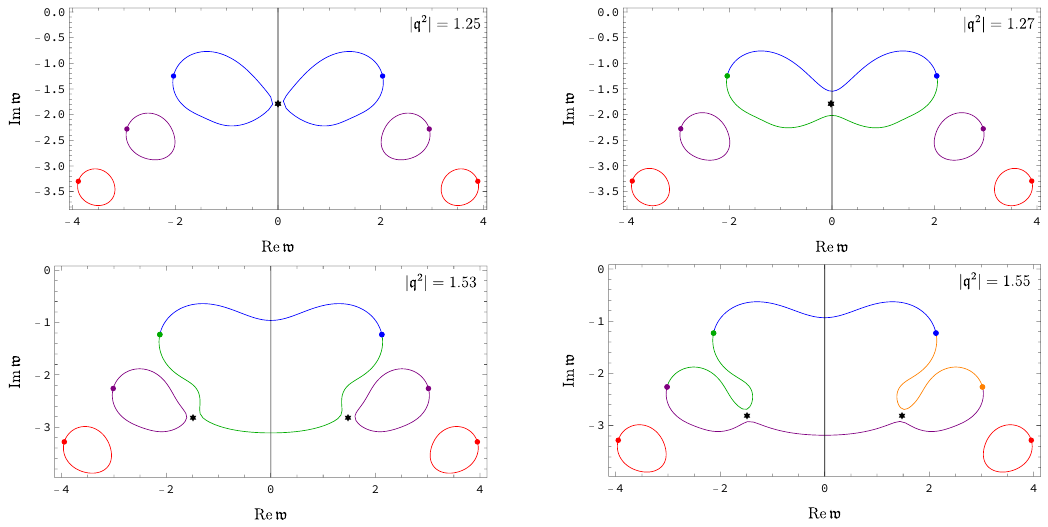
Figure 13 . Quasinormal spectrum (poles of the retarded energy-momentum tensor two-point function in the N = 4 SYM theory) in the scalar channel plotted in the complex w -plane for di(cid:11)erent values of the complex momentum q 2 = j q 2 j e i(cid:18) . Large dots in all plots correspond to the location of the poles for purely real momentum, q 2 (i.e. at (cid:18) = 0) [41]. There are no hydrodynamic modes in this channel, but the gapped modes exhibit the level-crossing phenomena at complex values of momenta given by eq.